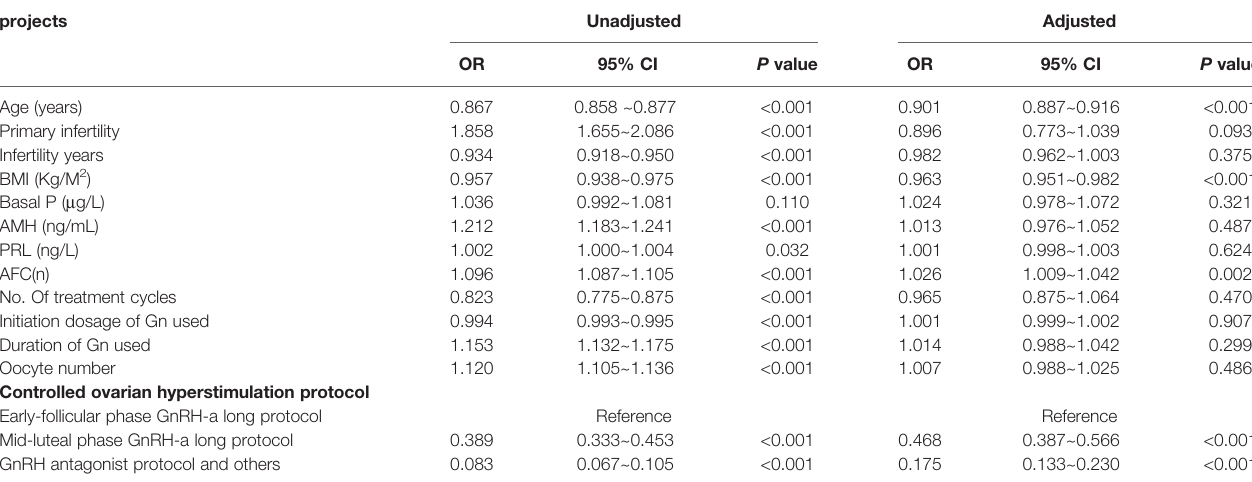
TABLE 2 | Logistic regression analysis of factors related to live birth.